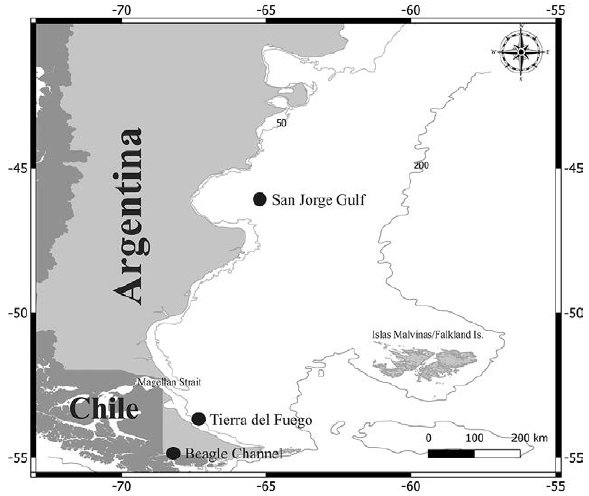
Fig. 1. – Southern tip of South America, showing the three sampling